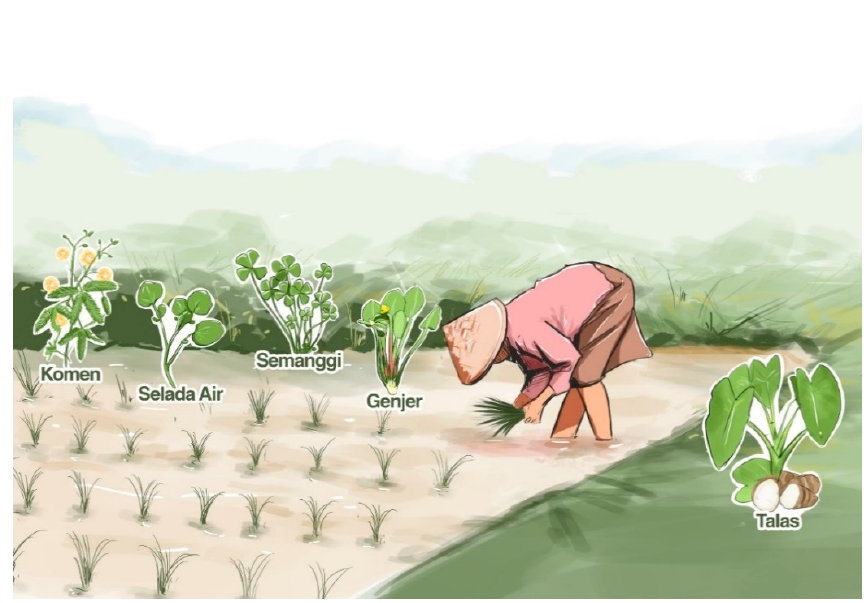
Figure 8. Illustration of wild vegetables naturally occurring in the organically managed rice field (adapted from the community guidebook by Pawera et al. [89]).